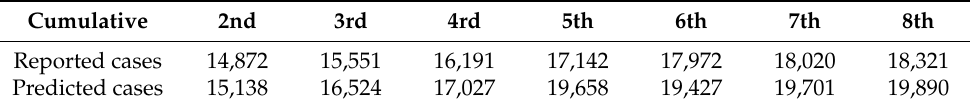
Table 3. Cumulative reported case data between the 2nd and 8th of May 2020, reported for Qatar by Worldometers a .